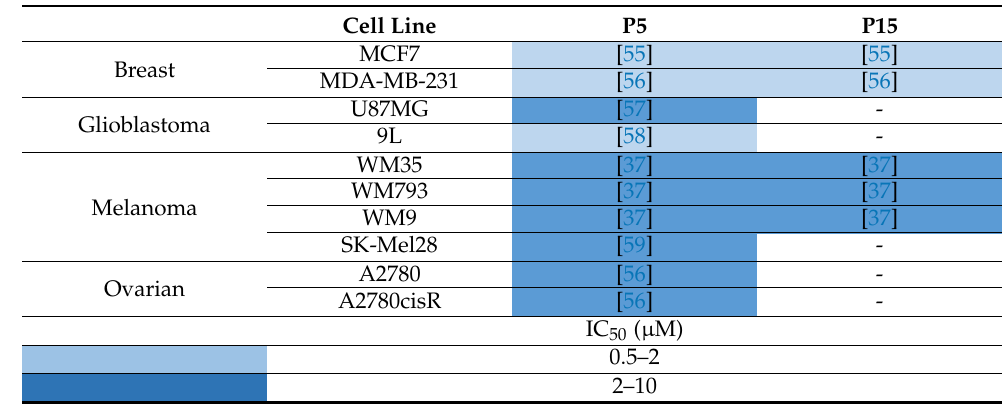
Table 2. IC 50 values in µ M on some cancer cell lines (breast, glioblastoma, melanoma and ovarian) of P5 and P15 ferrocifens.